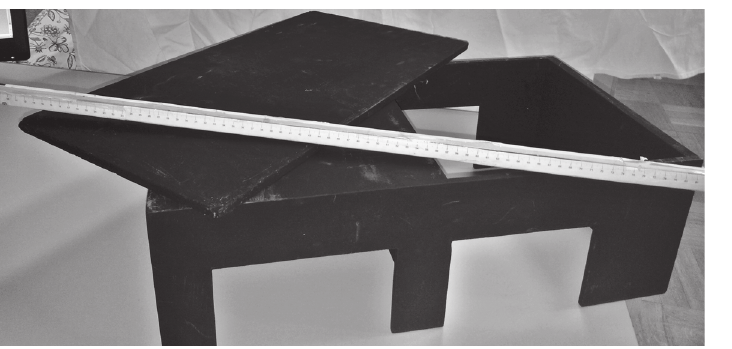
Fig 1. Picture of the materials employed in the